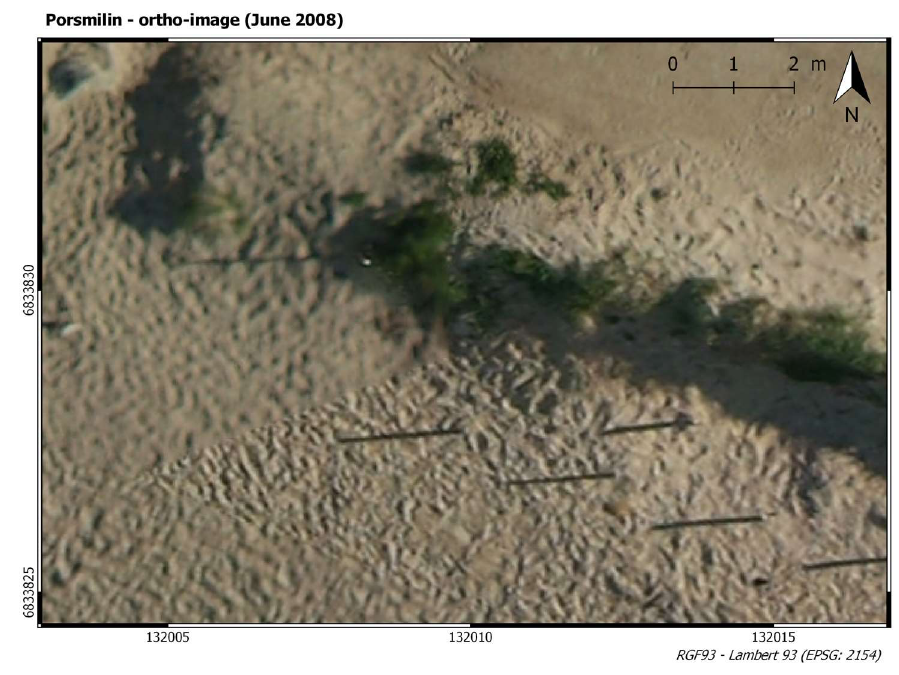
Figure 3. Portion of an orthoimage illustrating the variation in photograph quality during a flight performed in June 2008 with the Pixy® drone.